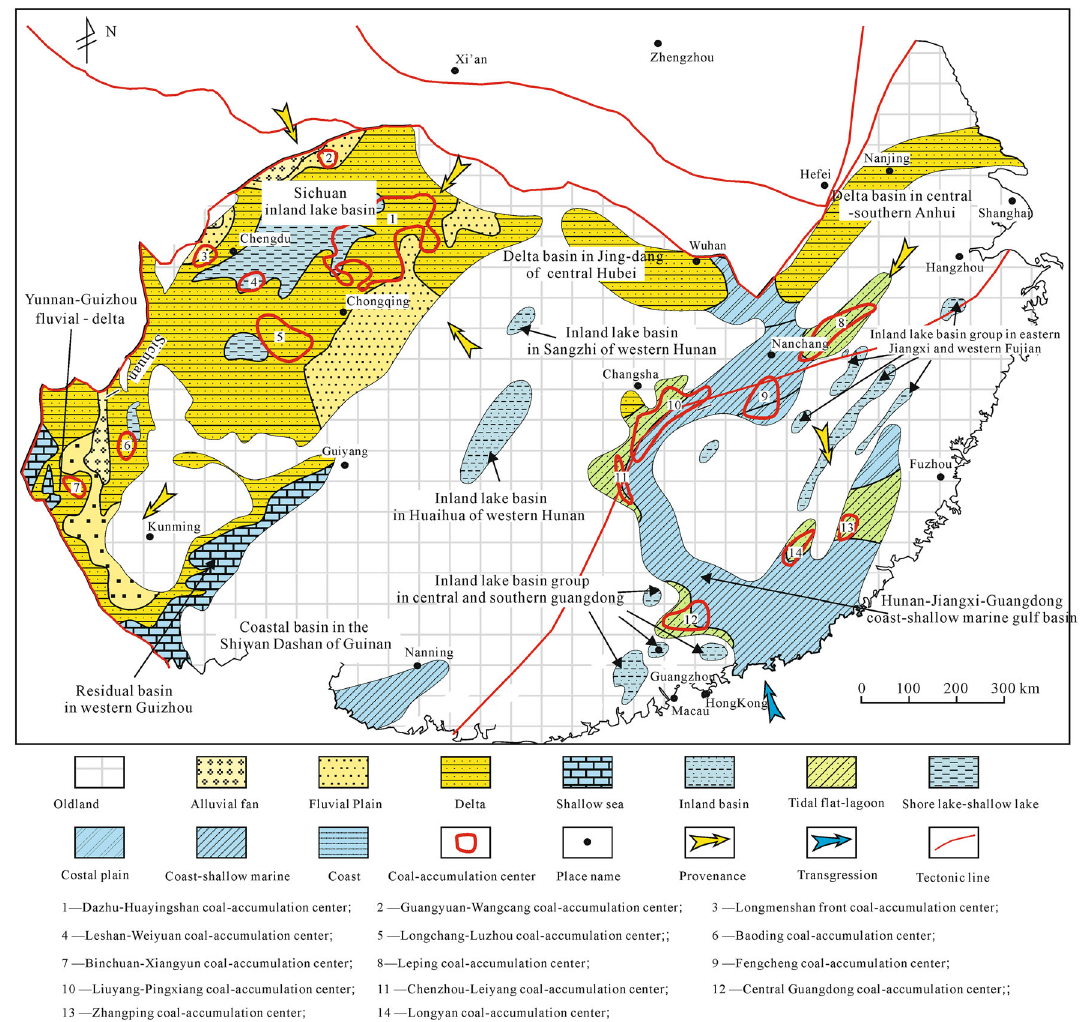
Fig. 11 Paleogeography and distribution of coal-accumulating centers of the Late Triassic in the South China CAA (modified after Shao et al.